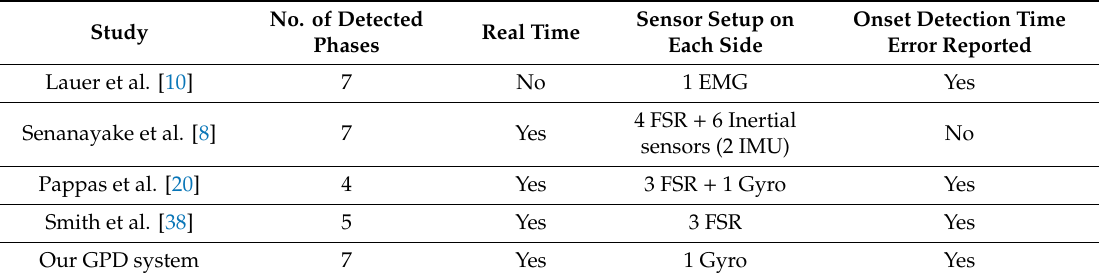
Table 5. Comparison of our GPD system to similar GPD systems from well-cited studies. Gray cells indicate relative shortcomings of the corresponding system. The last row is our GPD system.